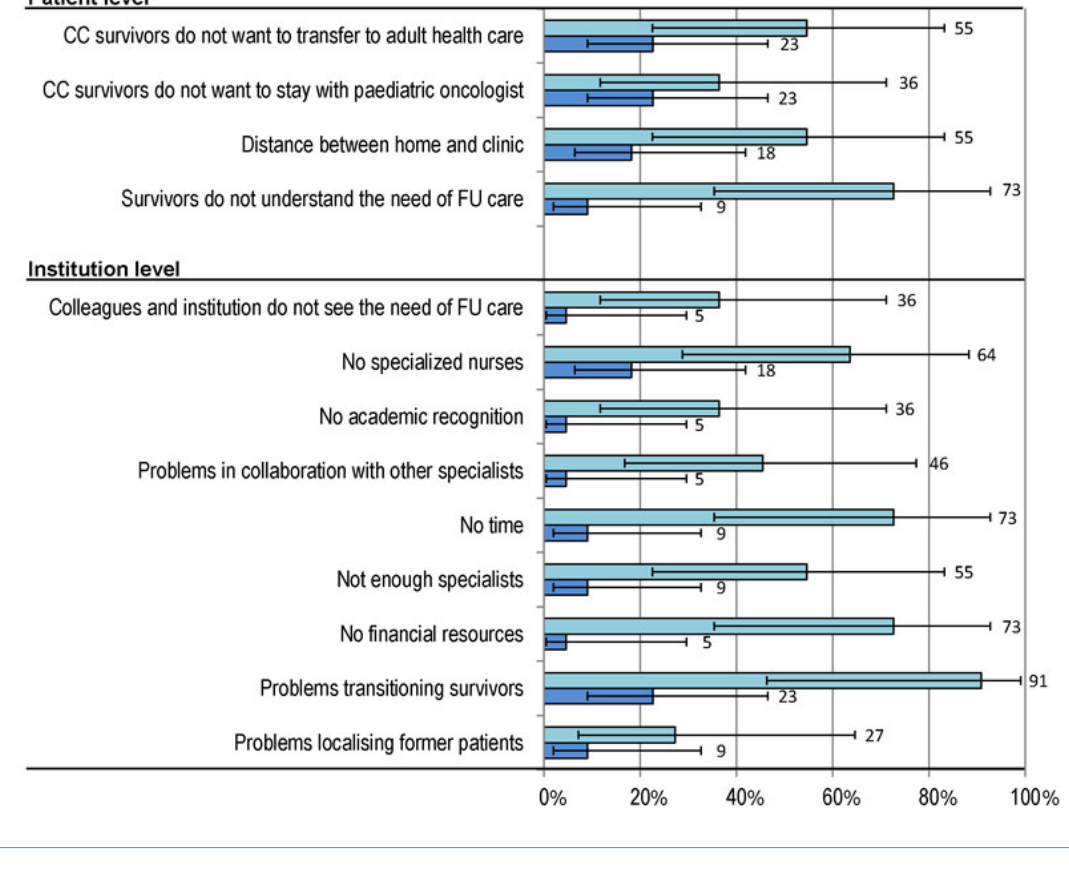
Figure 3: Problems with follow-up care reported by medical and paediatric oncologists.The bars and values at the end of the bars represent the proportion (%) of physicians who confirmed to have the respective problem, with 95% confidence intervals (indicated by the horizontal